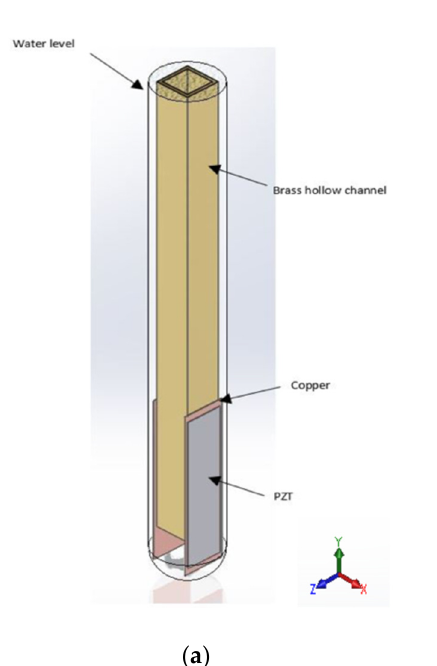
Figure 4. Model built in ANSYS: (a) schematic of the built model and fluid level; (b) the layers of the model; and (c) the mesh configuration.